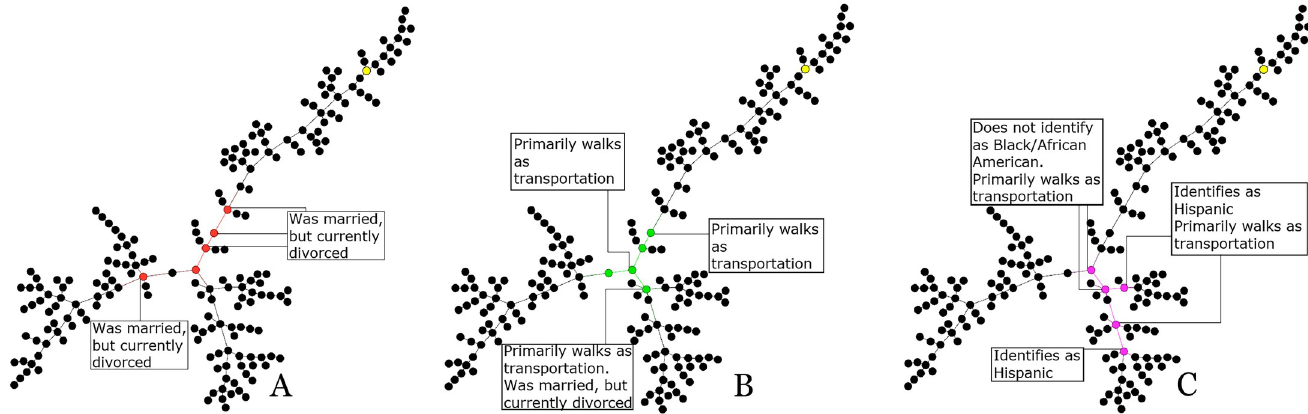
Fig 2. One component from the Chicago referral network, with nodes highlighted by centrality. A . Betweenness. B . Closeness. C . Eigenvector.